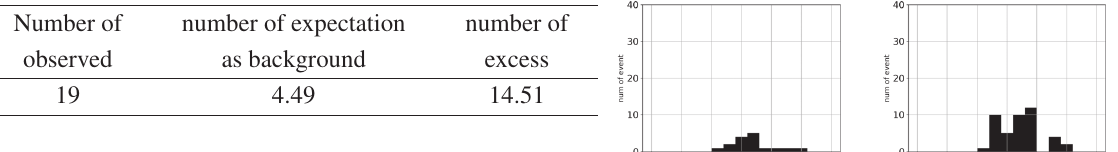
Table 3: Numbers of events in the Background and HotSpot regions in the first 5 years of the TA data.